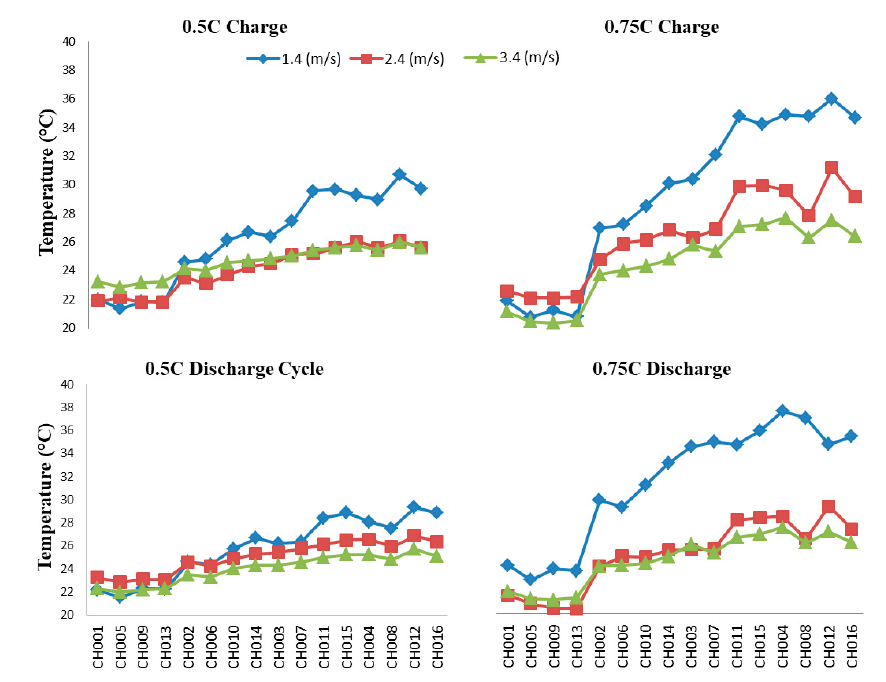
Figure 15. Thermal characteristics of the battery pack. Table 5. Disparities in Maximum Temperature of Cell 12 during Charge / Discharge